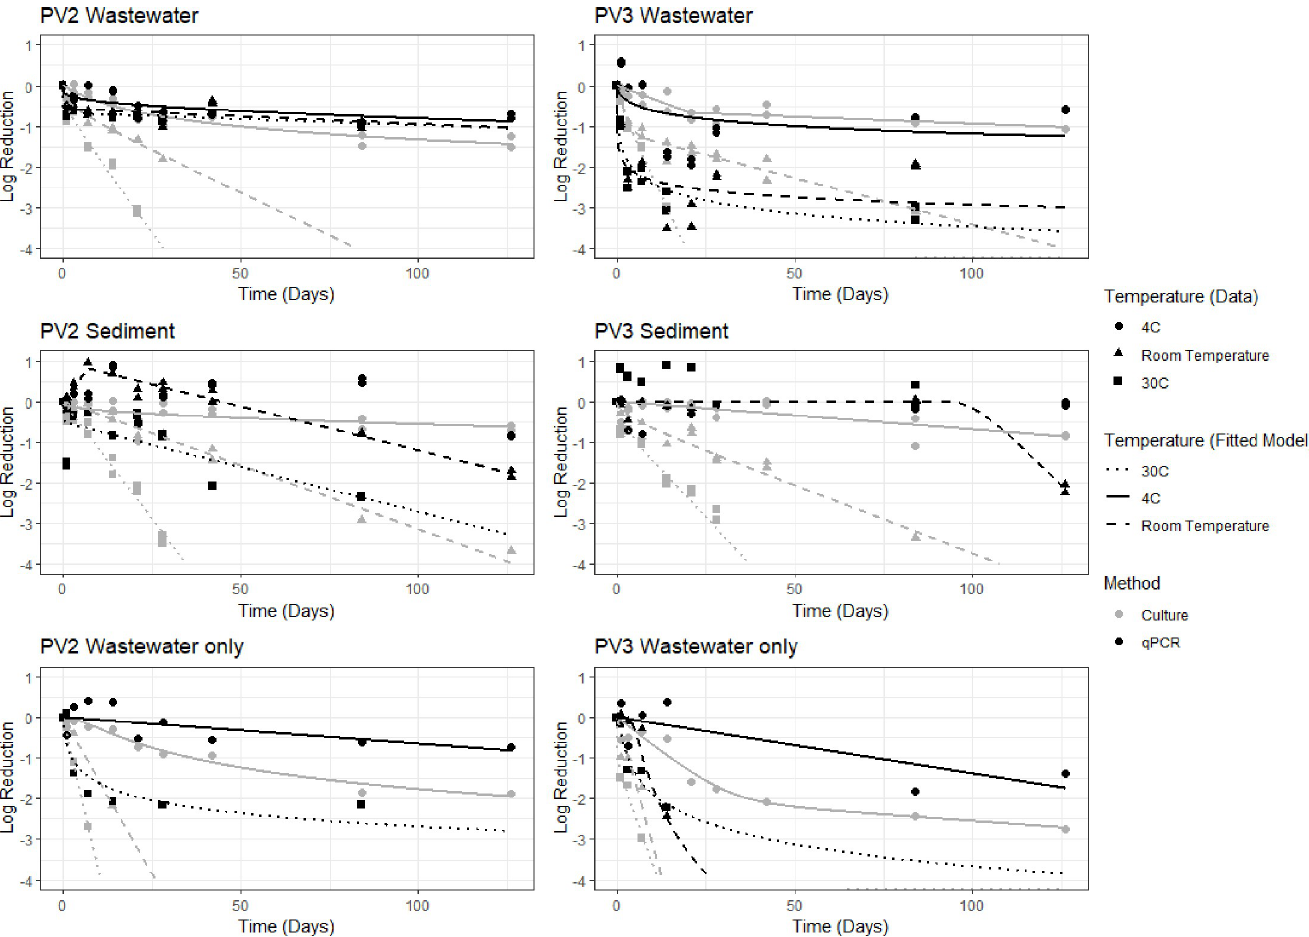
Fig 2. The best fitting model for each dataset separated by virus type and matrix. The data from culture experiments and the best fitting models to culture datasets are shown with grey points and grey lines. The data from qPCR experiments and the best fitting models to qPCR datasets are shown with black points and black